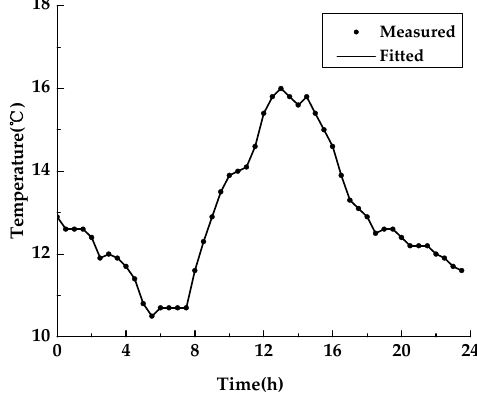
Figure 2. Measured and fitted solar radiation intensity on 24 August.